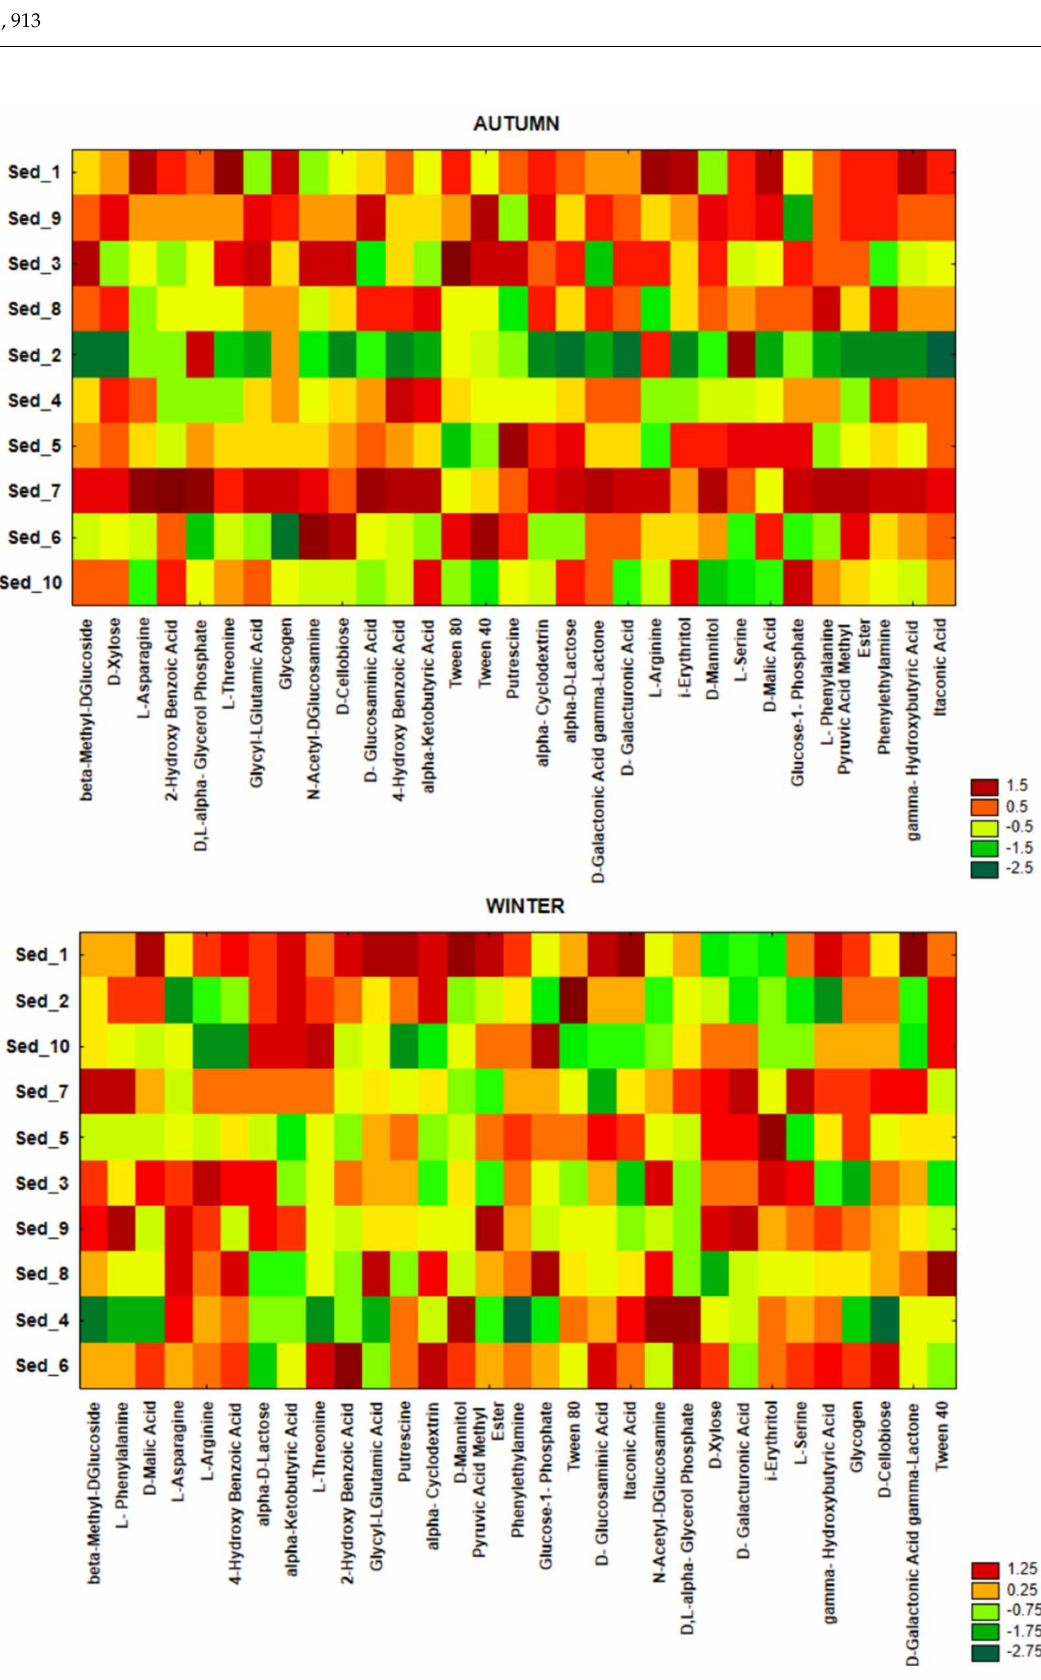
Figure A2. Heat maps of carbon utilization patterns of 31 substrates from the Biolog EcoPlates incubated for 120 h with the bottom sediments in Cardinal Pond. The results are visualized as standardized data of absorbance measurement at a wavelength of 590 nm (higher values mean higher functional